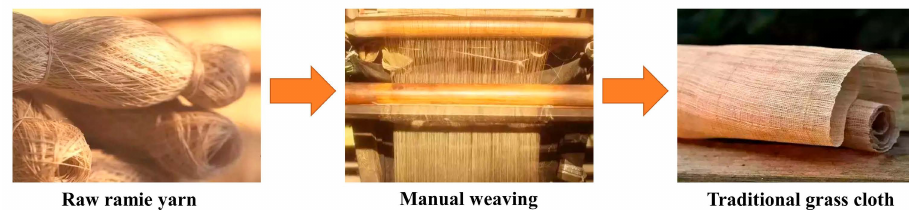
Figure 1. Preparation of traditional grass cloth.